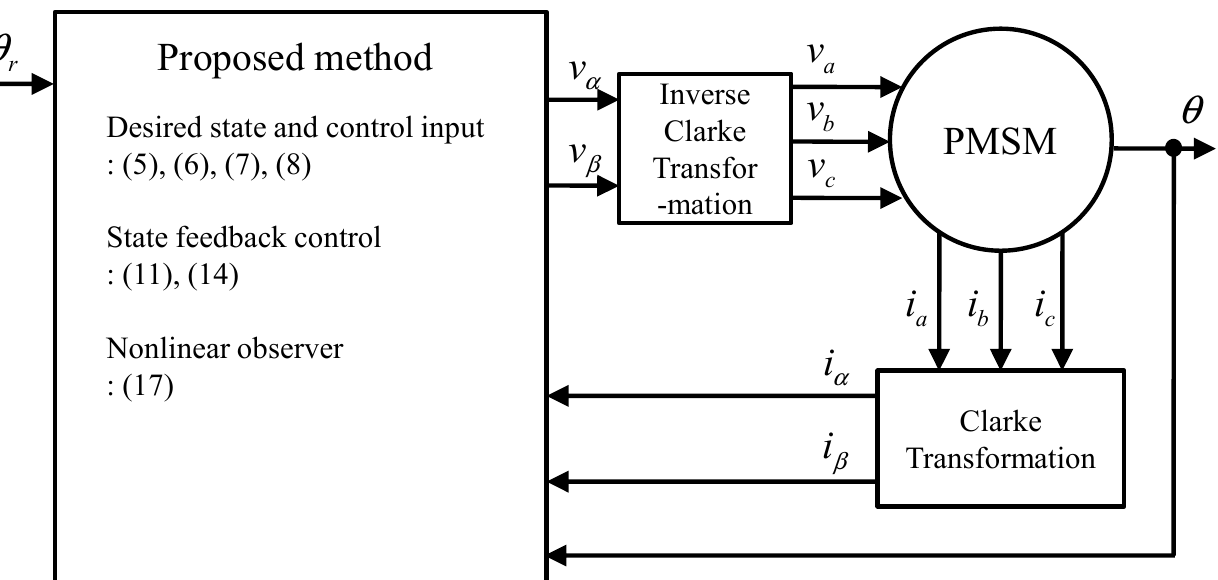
Figure 2. Block diagram of the proposed method.